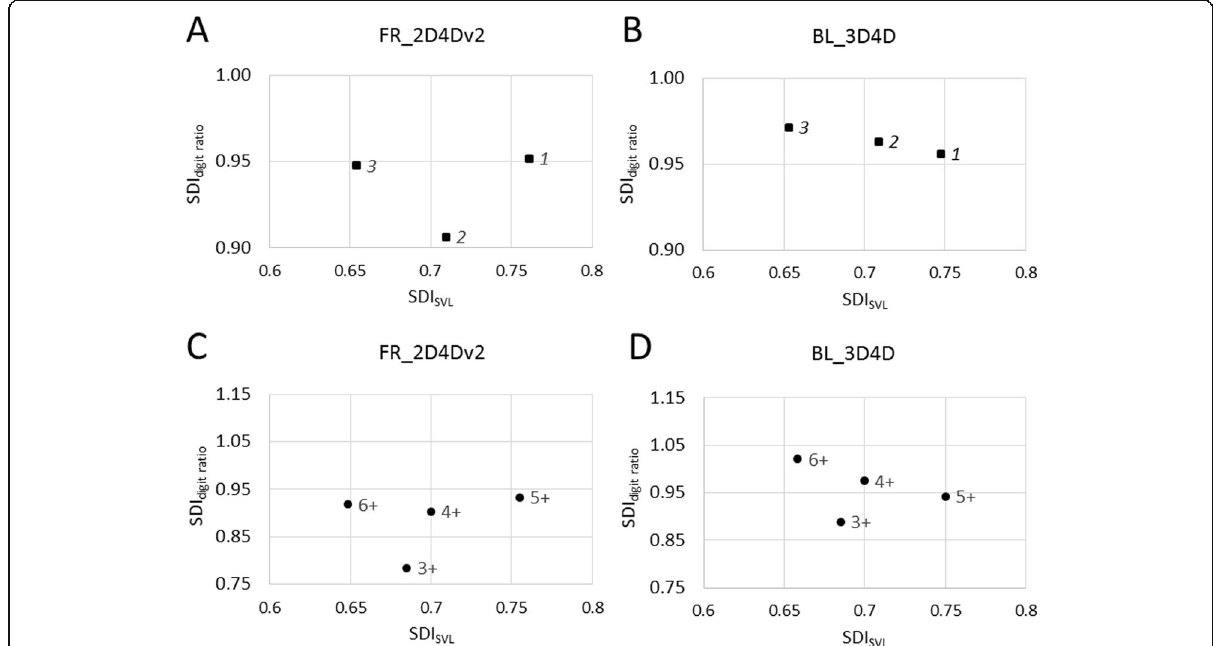
Fig. 3 Phenotypic integration: relationship between the sexual dimorphism index (SDI) of body size (SDI SVL , snout-vent length) and digit ratio (SDI digit ratio ) between three study sites marked as squares (panels: a , b ) and four age cohorts marked as dots (panels: c , d ). The digit ratio used was as follows: Panels a , c – right forelimb 2D:4D (variant II); Panels b , d – left hindlimb 3D:4D. Age results were obtained from the second dataset containing only individuals from site